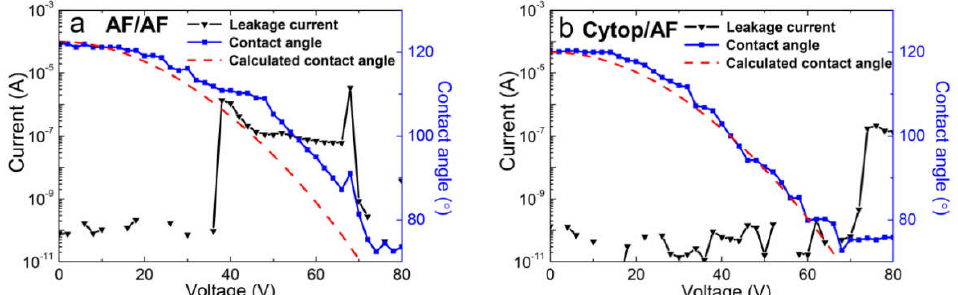
Figure 7. Leakage current and electrowetting measurement of bilayer fluoropolymer coatings with ( a ) 0.52 μm Teflon AF as the bottom layer and 0.09 μm Teflon AF as the top layer; and ( b ) 0.5 μm Cytop as the bottom layer and 0.06 μm Teflon AF as the top layer. Measured current in black (left axis) and contact angle data in blue (right axis) with Equation (1) modeled (red dashed line).